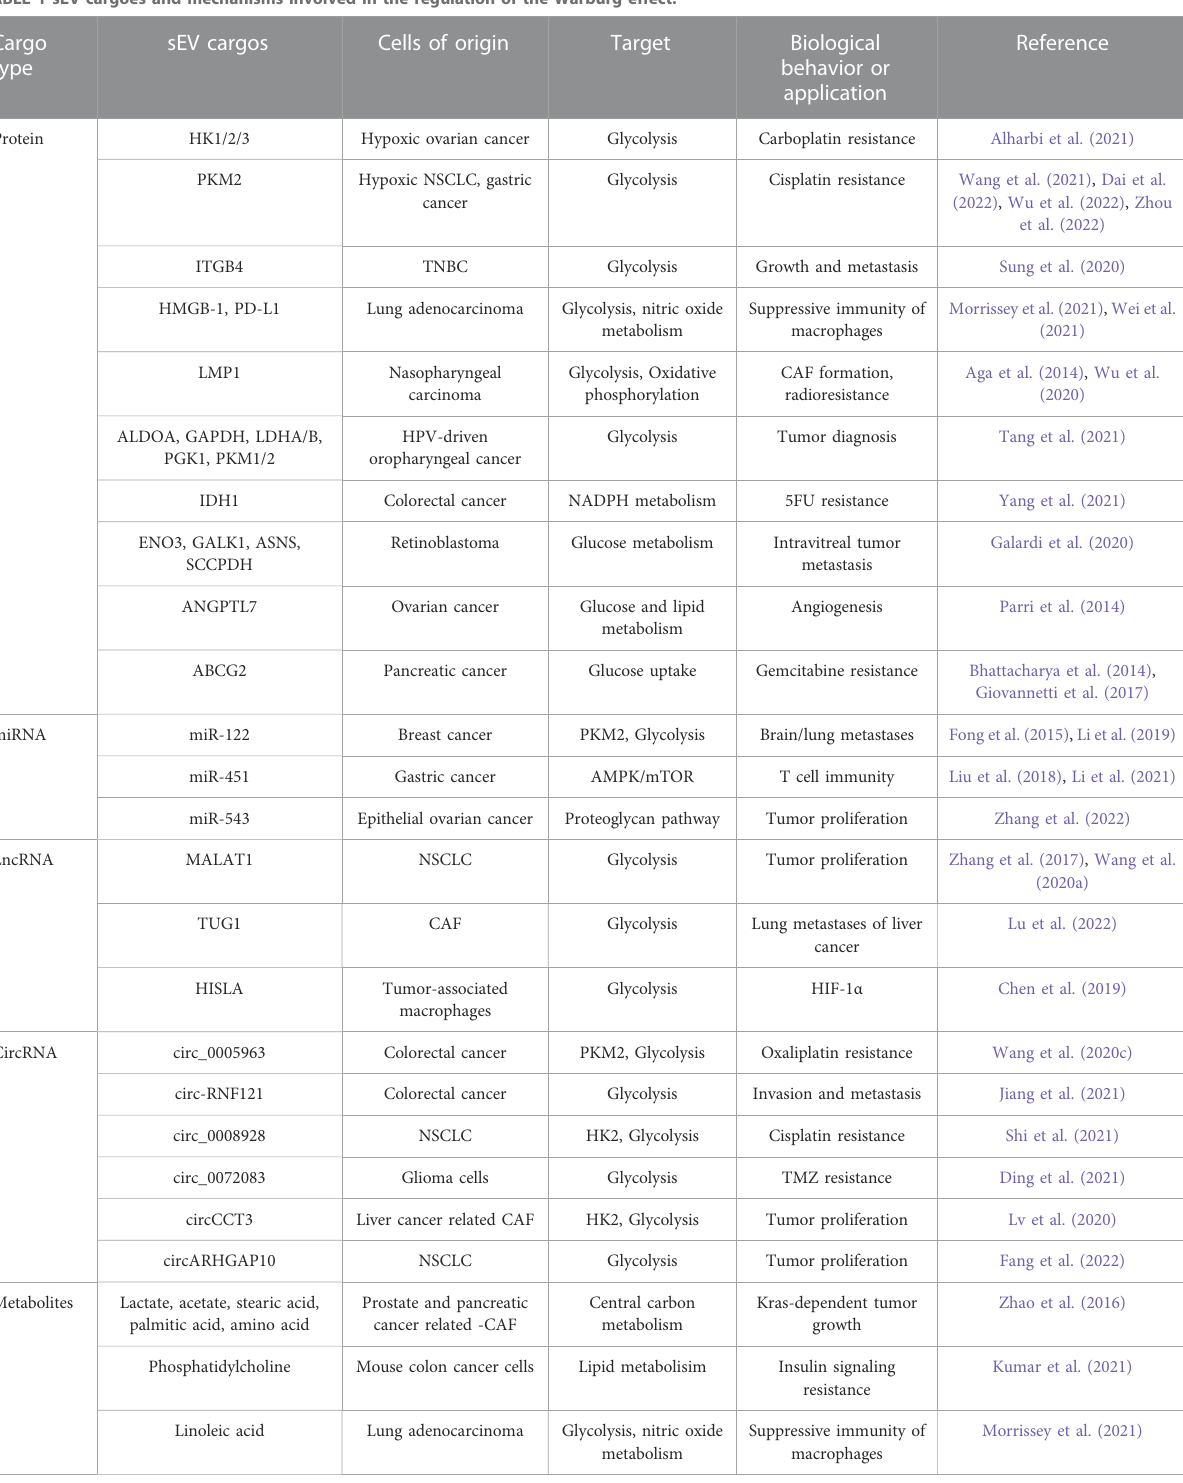
TABLE 1 sEV cargoes and mechanisms involved in the regulation of the Warburg